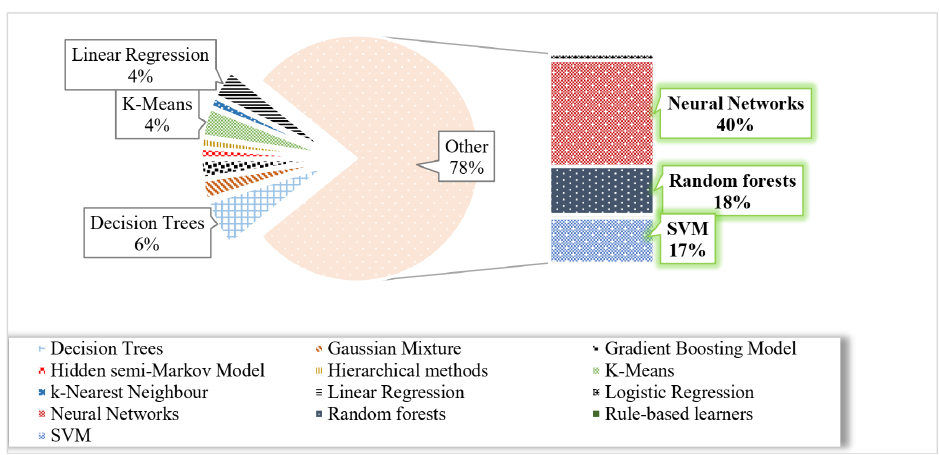
Figure 19. Percentages for each class of learning methods. Forty percent of publications (36 different papers) reported about NNS. The most sig- nificant contribution was from DL algorithms (highlighted with green clouds in Figure 20). DL for ML constituted 67% (24 proposed methods) of all NNs case test. With 22%, long short-term memory covered the prominent class of NNs methods. There was a 19% usage of deep neural network and an 11% of convolutional neural network. Artificial neural networks and Bayesian neural networks were implemented in 8% of publications.